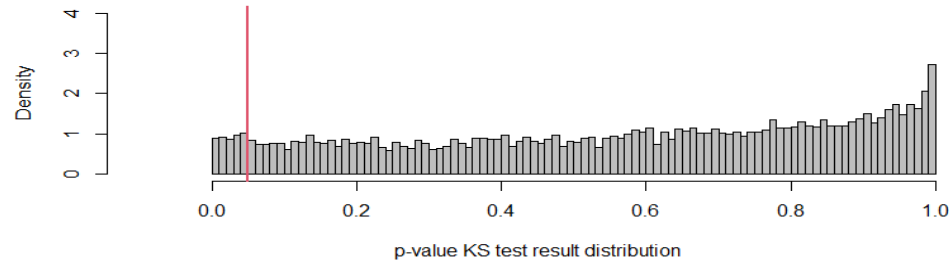
Figure 2. Bootstrap test of a linear combination of normalized logarithms of prices and pricing factors. In 9531 cases out of 10,000, the p -value of the Kolmogorov–Smirnov test was greater